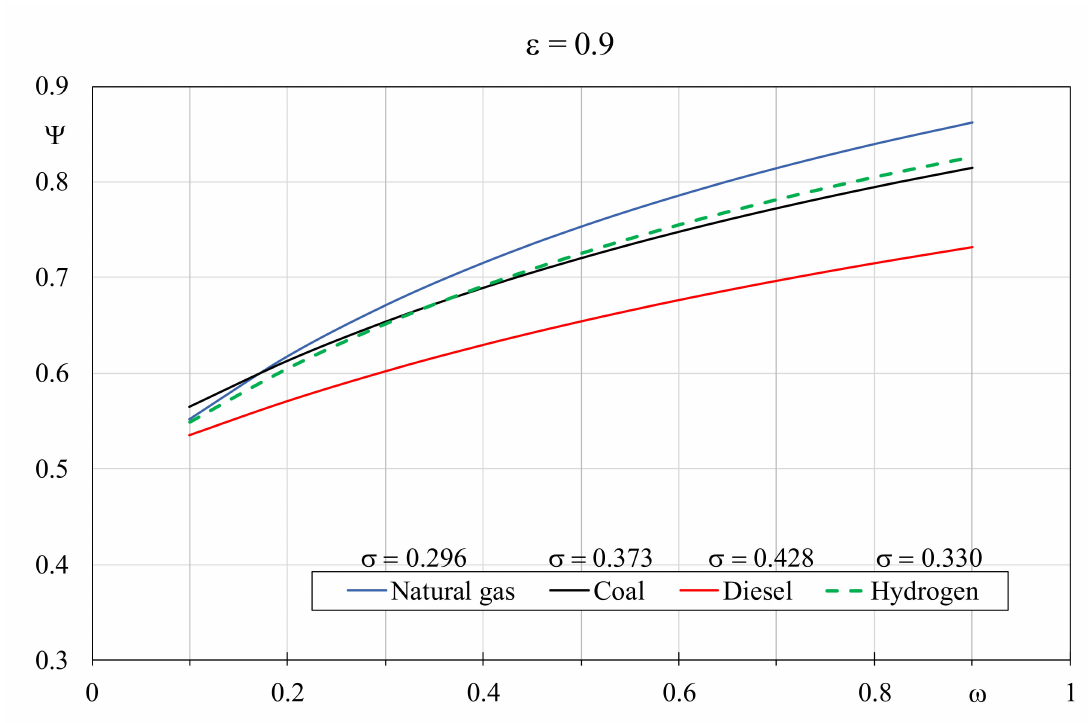
Figure 7. Comparison of the EQI related to the heat exchanger thermal capacity ratio for the considered fuels, with different values of the dimensionless temperature factor and setting ε = 0.9.